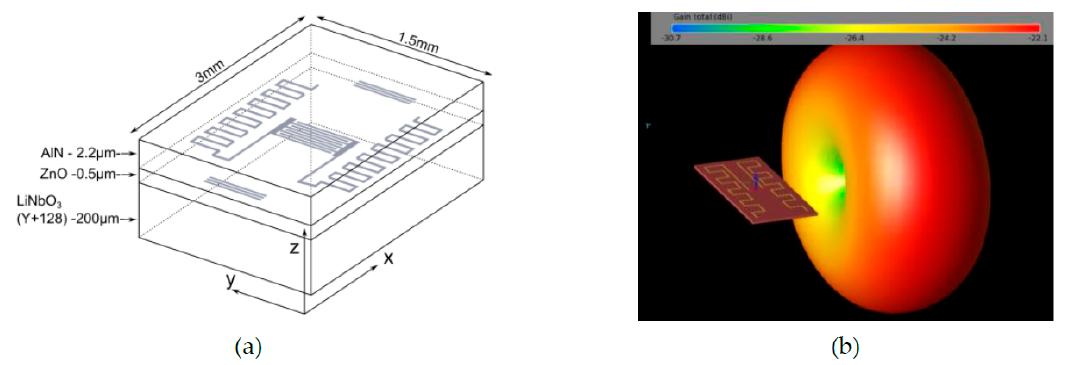
Figure 3. ( a ) Schematic description of an innovative AlN/ZnO/IDT/LN package-less SAW sensor, with embedded antenna. ( b ) Embedded antenna: simulation model and radiation pattern, at 1.97